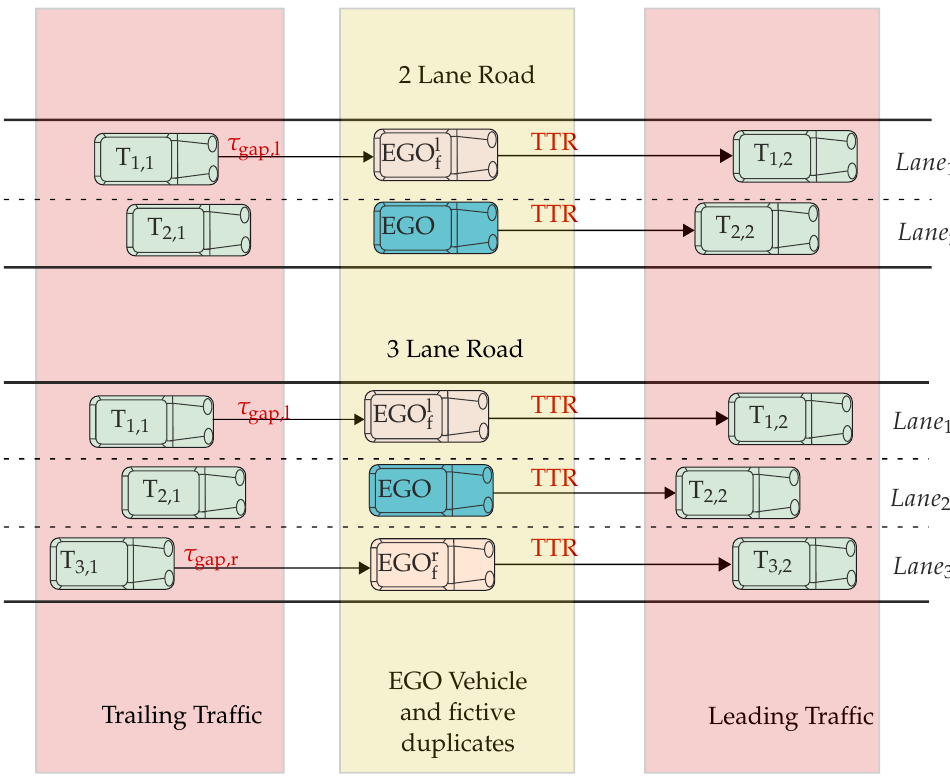
Figure 3. Graphical representation of the two-lane and three-lane